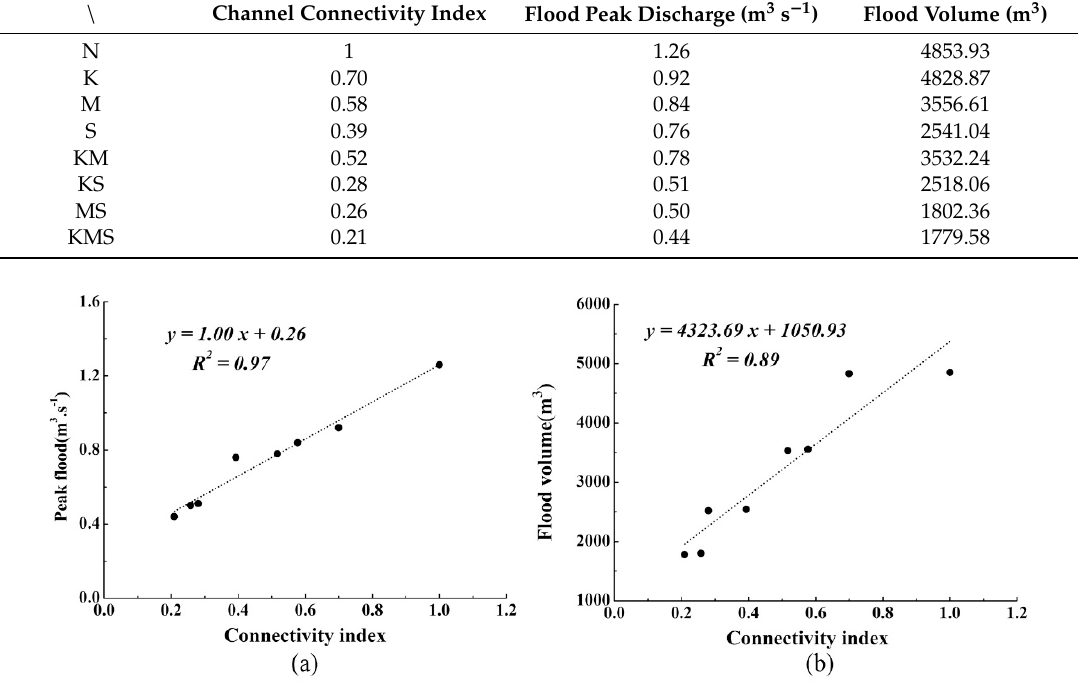
Figure 7. Relationships between channel connectivity index and peak flow (a); relationships between channel connectivity index and flood volume (b).